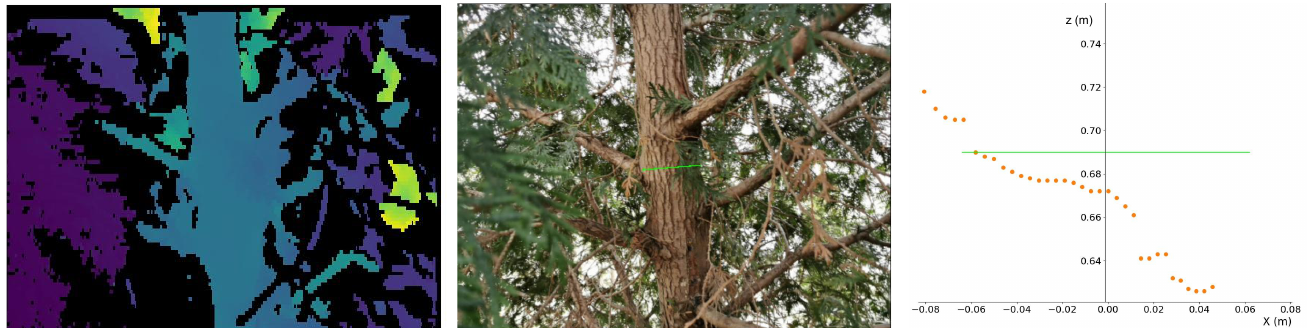
Figure 6. Circle-fitting is not straightforward for images taken in complex forest environments. Left : Raw depth image on which our app is able to estimate tree diameter with <1 cm of error. Center : RGB image with the green line indicating an estimated diameter line cross-sectioning the trunk. Right : Depth points are projected into real-world (x, z) coordinates (meters) along the cross-section identified in the center image. A circle-fitting approach would attempt to estimate a bounding circle for the trunk based on these